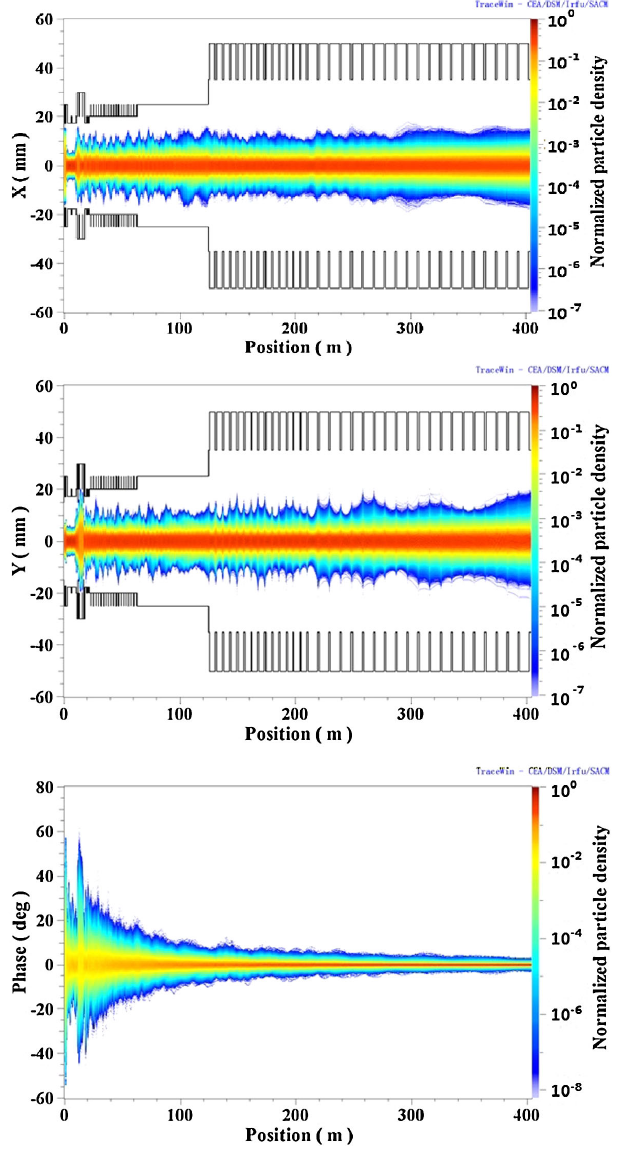
FIG. 34. Averaged power distribution of the lost particles along the linac.